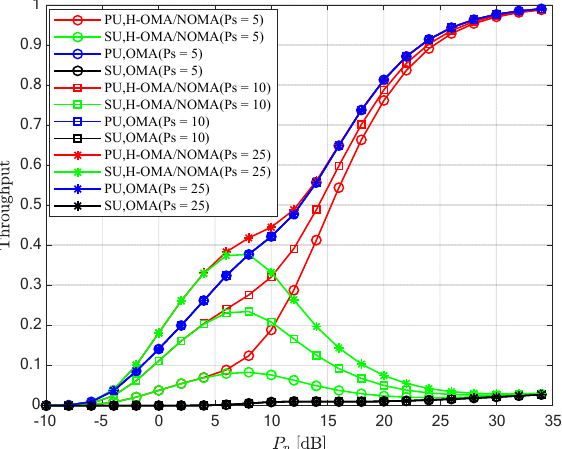
Figure 5. Throughput vs. PU’s transmit power P P with different SU’s transmit power P S